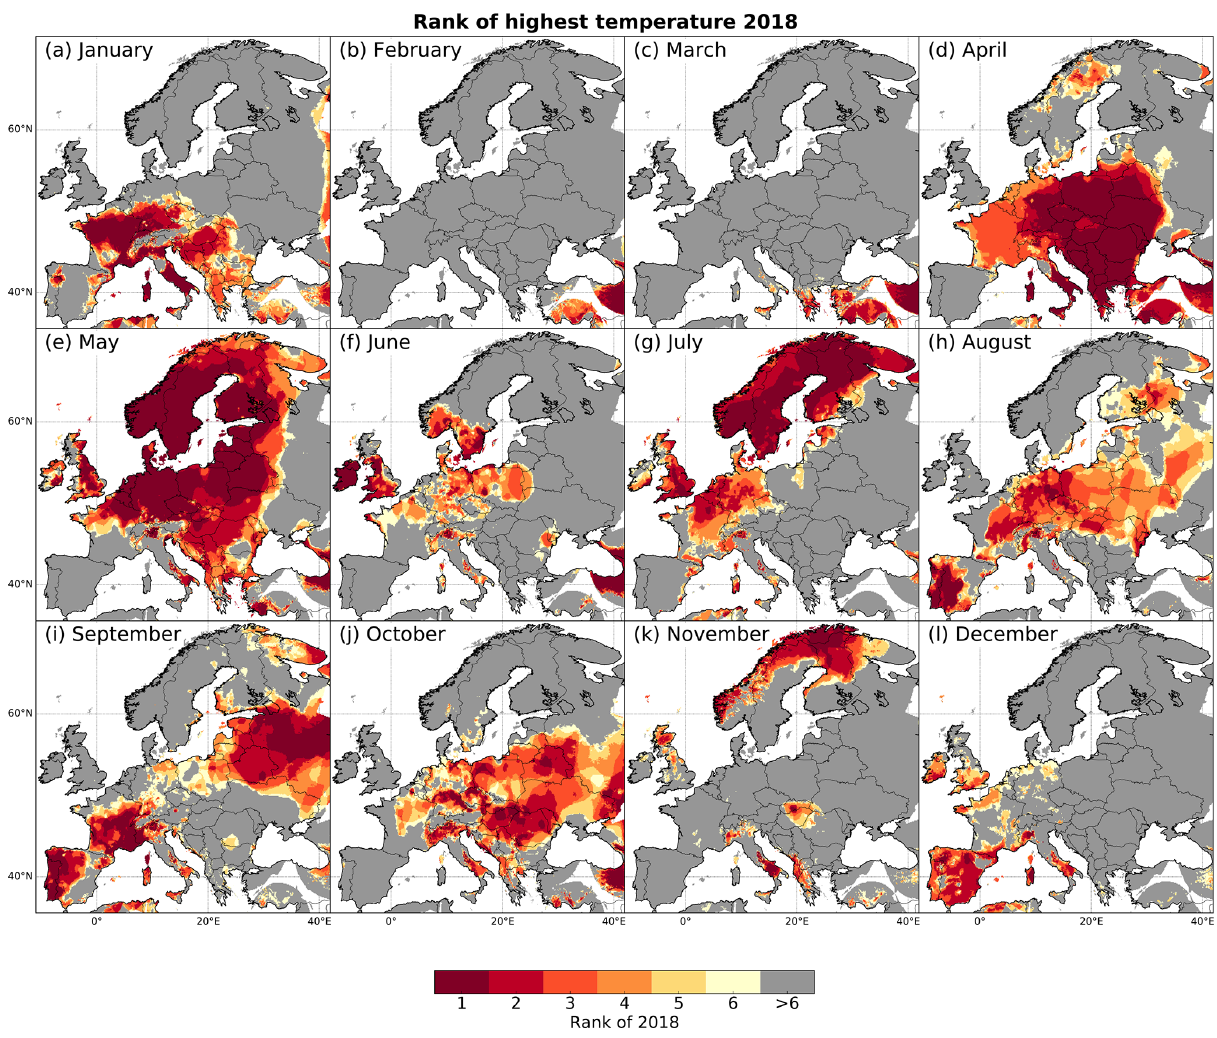
Figure A4. Top-six ranking of 2018 monthly highest temperature (monthly mean of daily maximum temperature) relative to the 60-year period